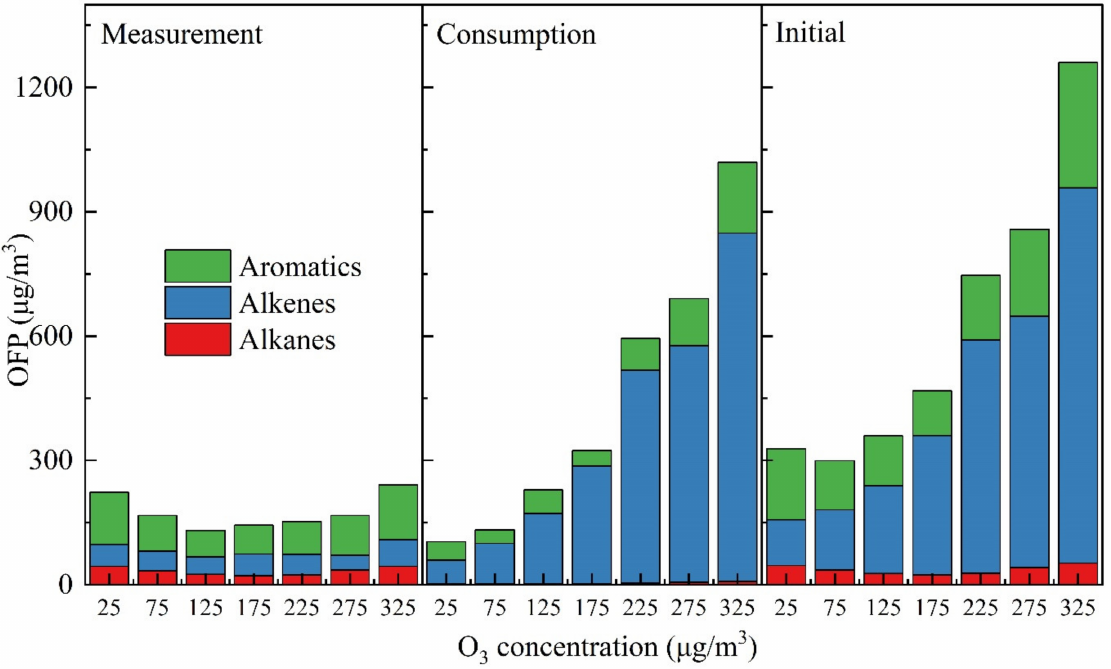
Figure 7. OFP of VOCs measured ( left ), consumed ( middle ), and initial (right ) concentrations at different O 3 concentration segments during the observation